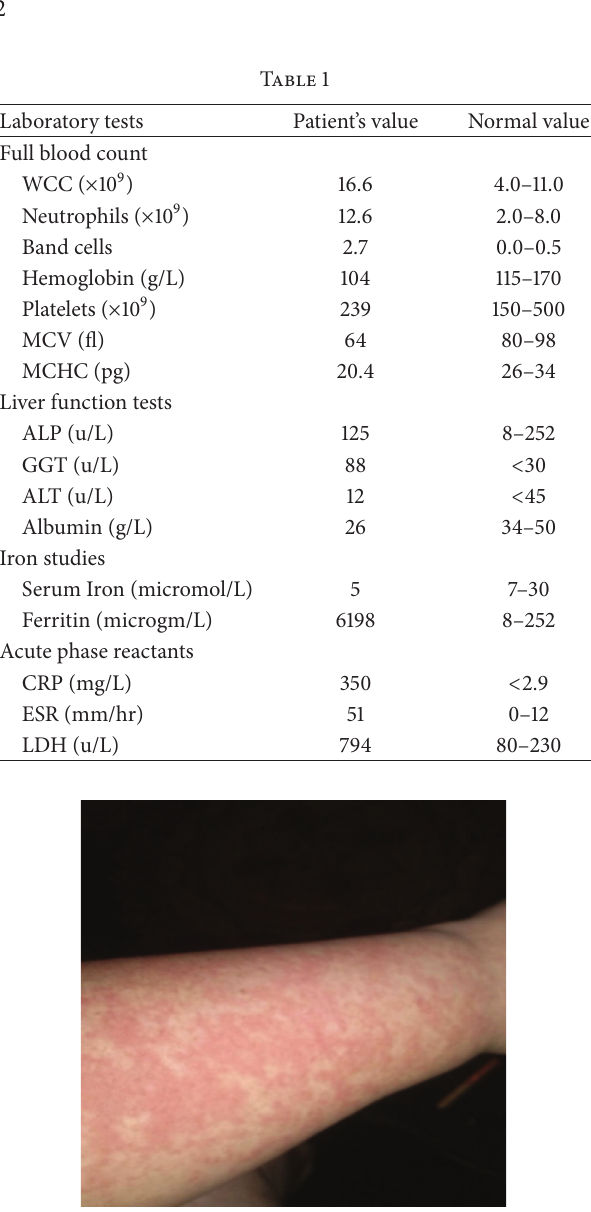
Figure 1: Maculopapular rash involving left forearm.